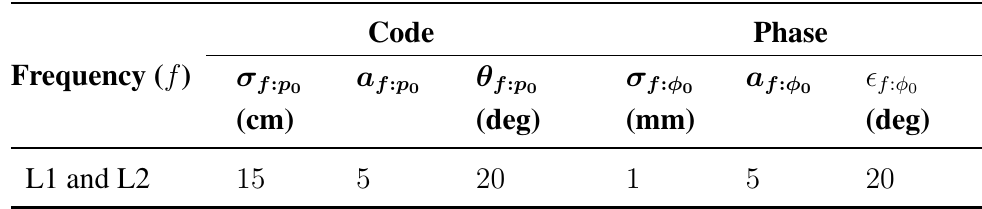
Table 1. Elevation-dependent stochastic model parameters defined in Equation (6).